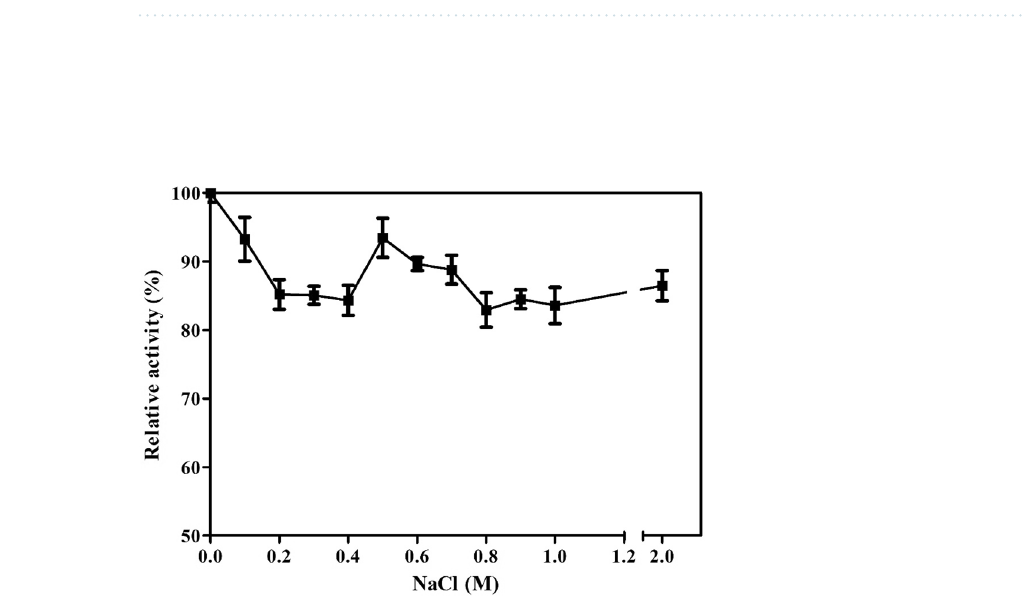
Figure 9. Enzyme stability when submitted to heat treatments of 45 and 50 °C for up to 60 min. Values are represented as the mean ± standard deviation.